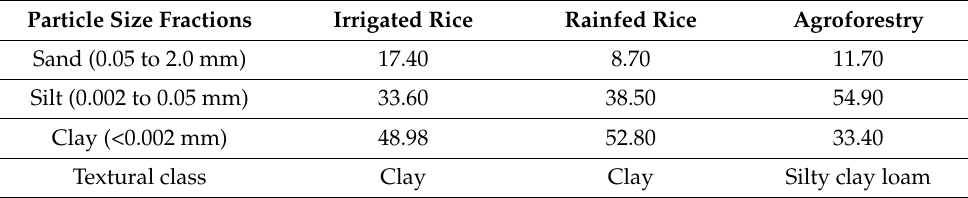
Table 1. Distribution of mineral particles and soil textural class in the studied plots.